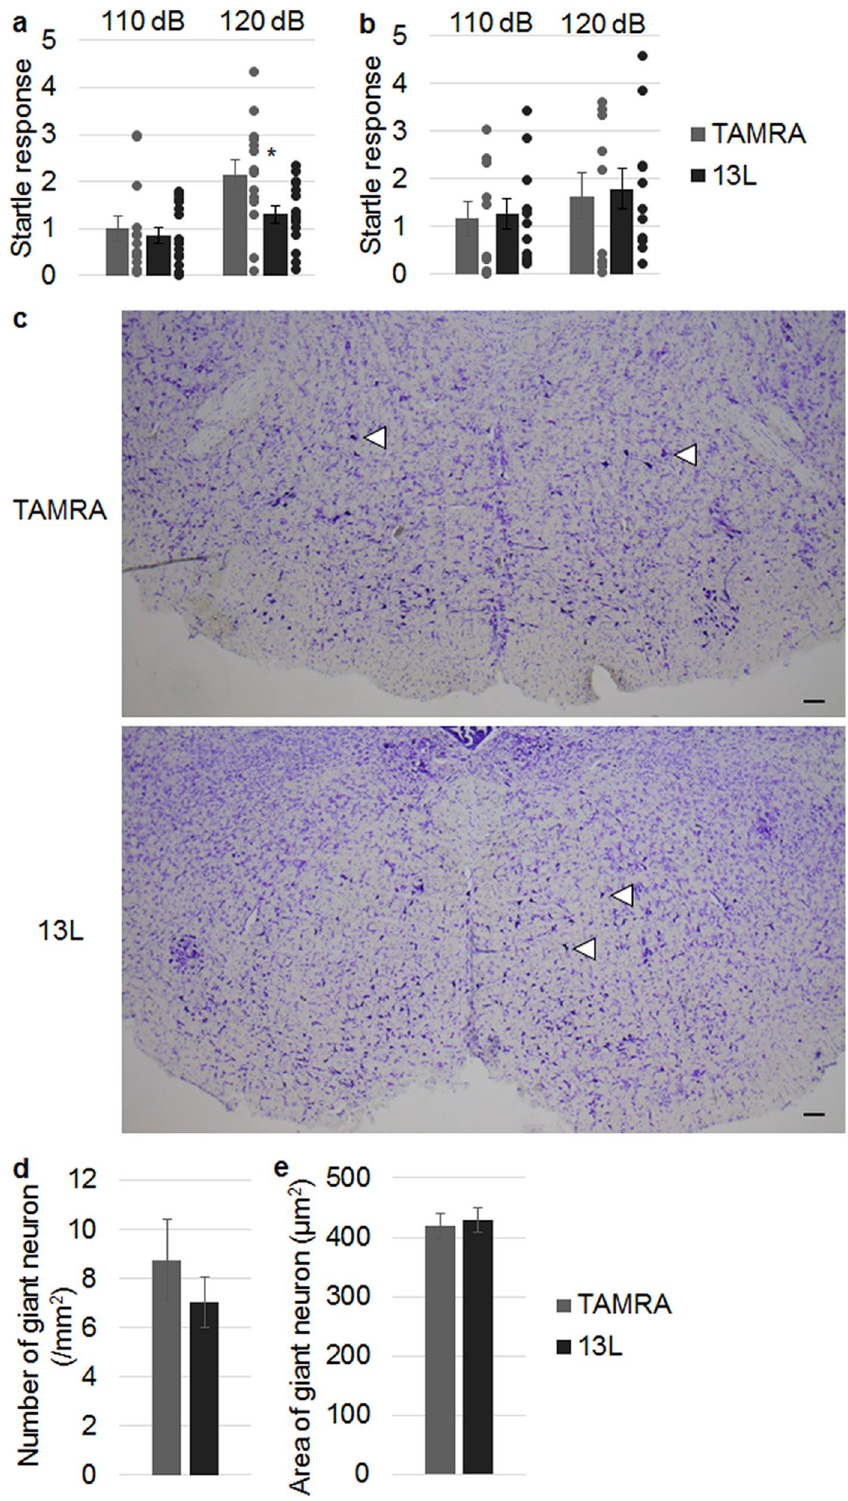
Figure 7. Reduced startle response in mice to which CM derived from 13L-treated BV2 microglia was injected into PnC. ( a ) Startle responses in mice to which CM from TAMRA-treated (n = 14, 9 males and 5 females) or 13L-treated (n = 15, 10 males and 5 females) BV2 microglia was injected into the PnC. ( b ) Startle responses were also measured in mice to which heat-denatured BV2-CMs were injected into the PnC. n = 10 (5 males and 5 females) and n = 11 (5 males and 6 females) for TAMRA-treated BV2-CM and 13L-treated BV2-CM, respectively. ( c – e ) The number ( d ) and size ( e ) of giant neurons (arrowheads in panel c ) in the PnC of Nissl- stained coronal brain sections from TAMRA-CM- and 13L-CM-injected mice were compared (data were obtained from 6 male mice, each). Scale bar 100 µm. Error bars represent SE. ANOVA, *p <